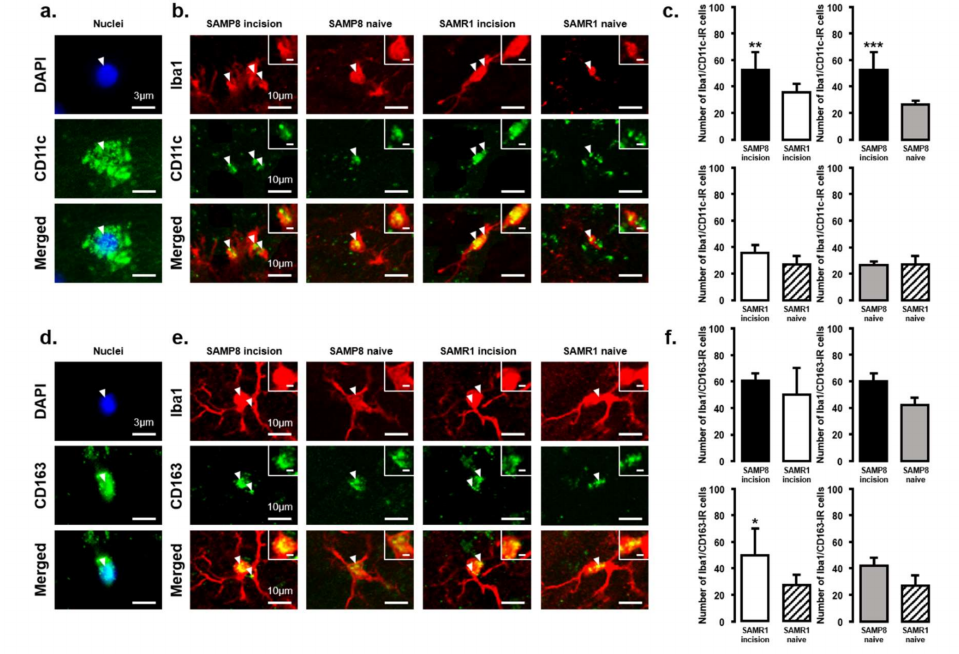
Figure 3. M1 / M2 polarization in microglia in the Vc and C1 / C2 regions on day 3 after palatal